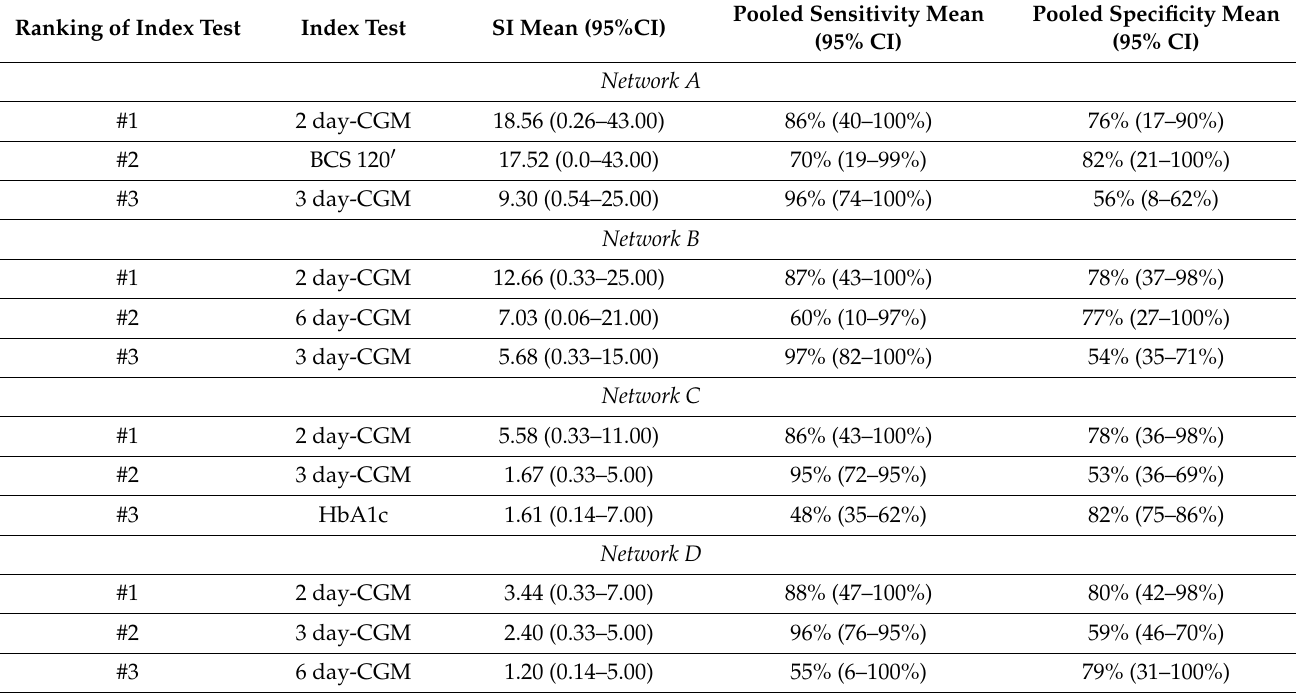
Table 2. Ranking table of the top three index tests by superiority